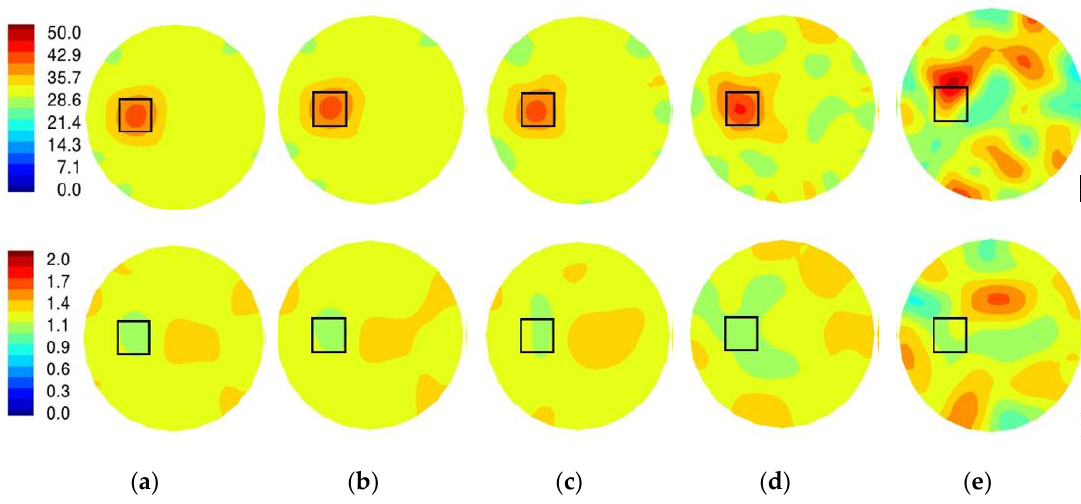
Figure 12. Reconstructed relative permittivity ( top ) and conductivity ( bottom ) at 1100 MHz for ( a ) no signal leakage, and ( b – e ) signal leakage of −130 dB, −120 dB, −110 dB, and −100 dB, respectively, of the square object depicted in Figure 5 for the 14.2 cm diameter field of view.